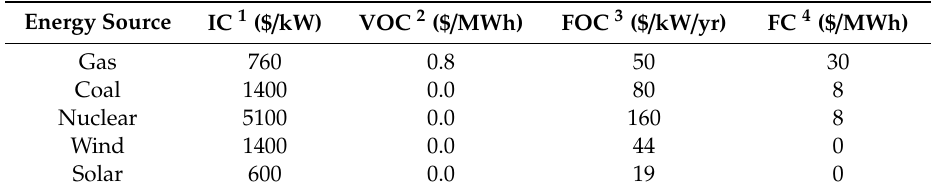
Table 1. Adapted cost parameters of the energy source for rLCOE from [36].